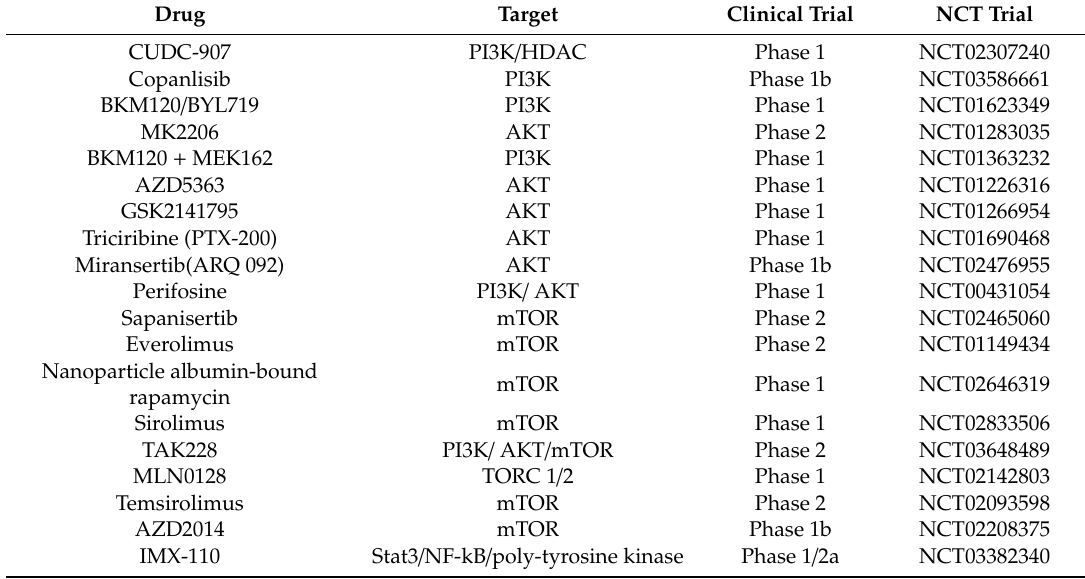
Table 3. Current clinical trials targeting the PI3K / AKT / mTOR / NF κ B pathway in